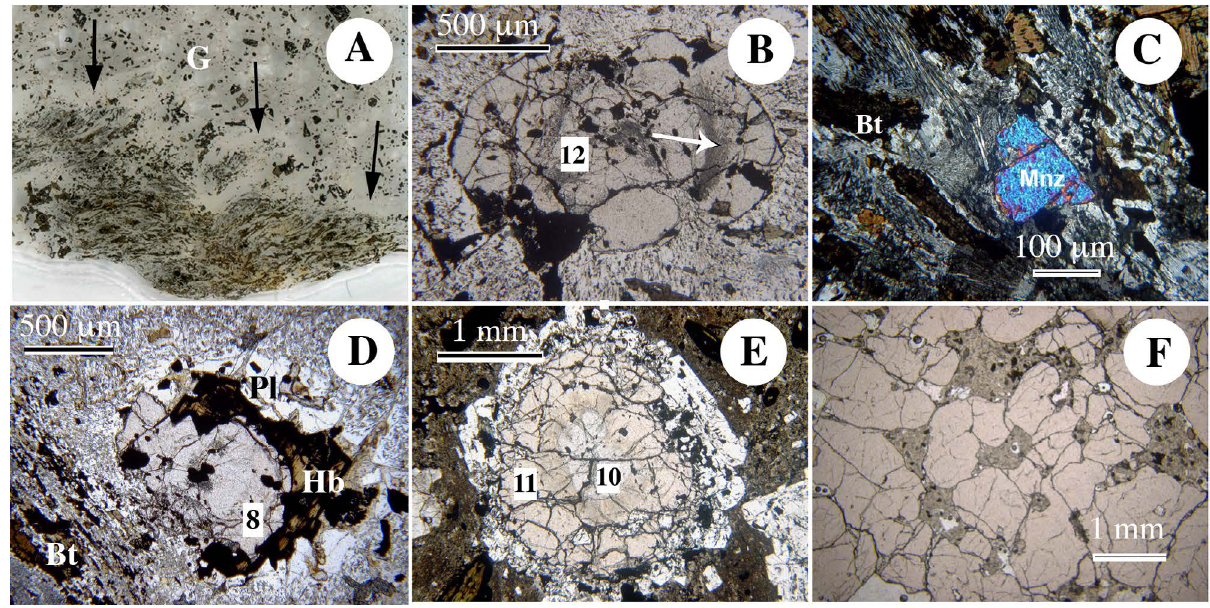
Figure 3: Petrographic features of the metasedimentary enclaves and garnetite lenses. Mineral abbreviations after Whitney and Evans [2010]. Numbers in white boxes refer to garnet analyses in Table 2. [A] General appearance of a metasedimentary enclave (thin-section scan, width of view 40 mm). The well-developed cleavage is marked by biotite. The coarse-grained reaction-rim appears as a light-coloured, leucocratic halo (arrows). Enclosing lava is visible in the upper part (G = groundmass). [B] Microphotograph of a typical metamorphic garnet in the core of a metapelitic enclave. Ilmenite inclusions (black) are numerous, and aggregates of fibrous sillimanite (white arrow) outline an internal irregular ring. Also present are plagioclase and biotite in the matrix around garnet. PPL. [C] Monazite crystal. Crossed-polarised light. [D] Close-up view of the granular selvage developed around metapelitic inclusions. Garnet and brown hornblende in a matrix of plagioclase (clear or altered). Note the slight difference in colour between the core of the garnet and its rim (pinkish). Number in the white box refers to garnet analysis in Table 6. Biotite (Bt) in the lower left corner marks the edge of the gneissic xenolith. PPL. [E] Composite garnet megacryst most probably expelled from the neighbouring (5 mm) metasedimentary enclave. The colourless core of metamorphic origin and the large magmatic overgrowth, slightly coloured in light-orange, are clearly distinct. The large reaction-rim is mainly composed of plagioclase (white). See X-Ray map and corresponding line profile